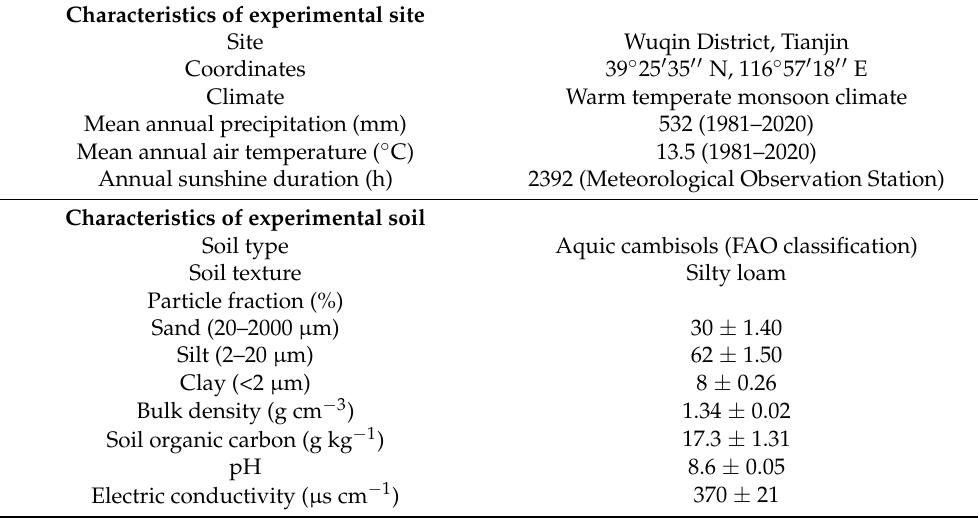
Table 1. General climatic characteristics at the experimental site and main soil properties of green- house soil (0–30 cm